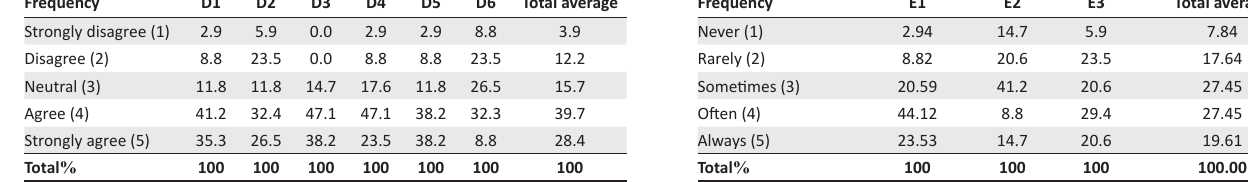
TABLE 4 : The MuniMEC inter-government relations structure legal framework. Frequency